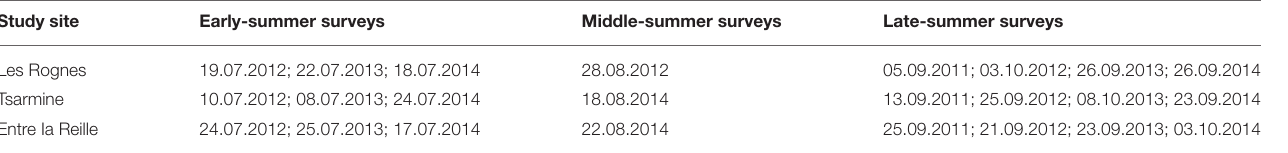
TABLE 1 | Date of dGPS surveys in each study